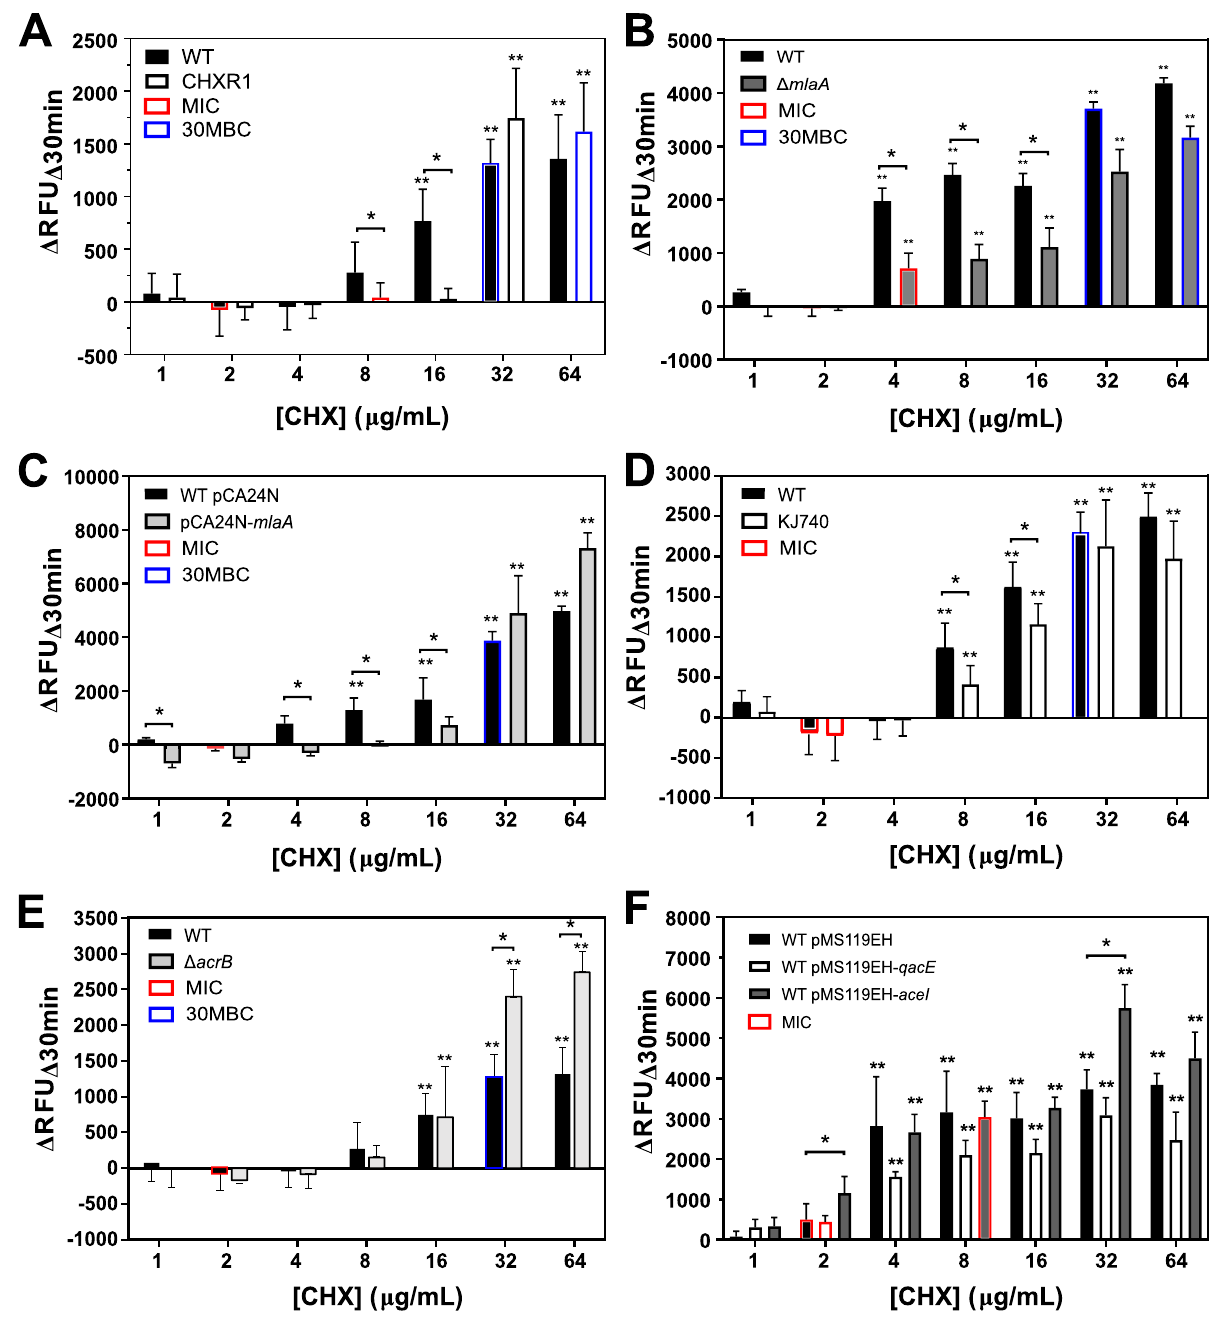
Figure 1. RFDMIA of E. coli K-12 BW25113 (WT), CHX-adapted isolate (CHXR1), single gene deletion mutants and plasmid transformants exposed to increasing CHX concentrations. In each panel, the mean ΔRFU Δ30 min value at tested CHX concentration ranges of 1–64 µg/mL are shown for: ( A ) RFDMIA of WT and CHXR1 isolates, ( B ) Δ mlaA (JW2343-KC) and WT, ( C ) WT pMS119EH-mlaA and pMS119EH transformants, ( D ) KJ740 (Δ ompC , Δ ompF ) and WT, ( E ) Δ acrB (JW0451-KC) and WT, ( F ) WT pMS119EH- qacE , pMS119EH- aceI and pMS119EH transformants. Statistical analysis of each RFDMIA plot involved Mann–Whitney U tests and was used to identify the lowest CHX concentration with a significant increase in ΔRFU Δ30min value (**) for the same sample with P -values ( P < 0.05). This test was also used to determine P < 0.05 for significantly different ΔRFU Δ30min value comparisons between the control and the measured sample at the same CHX concentration and is denoted as horizontal lines with an asterisks (*). Bar plots represent a minimum of three bacterial bioreplicated cell suspensions measured in three technically replicated samples (n =